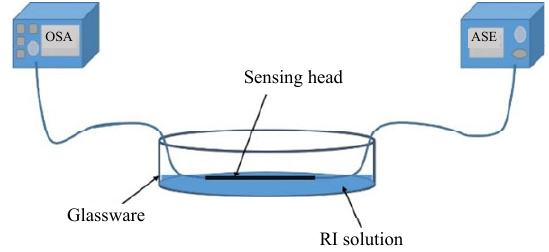
Fig. 2 Schematic diagram of the experimental measurement.